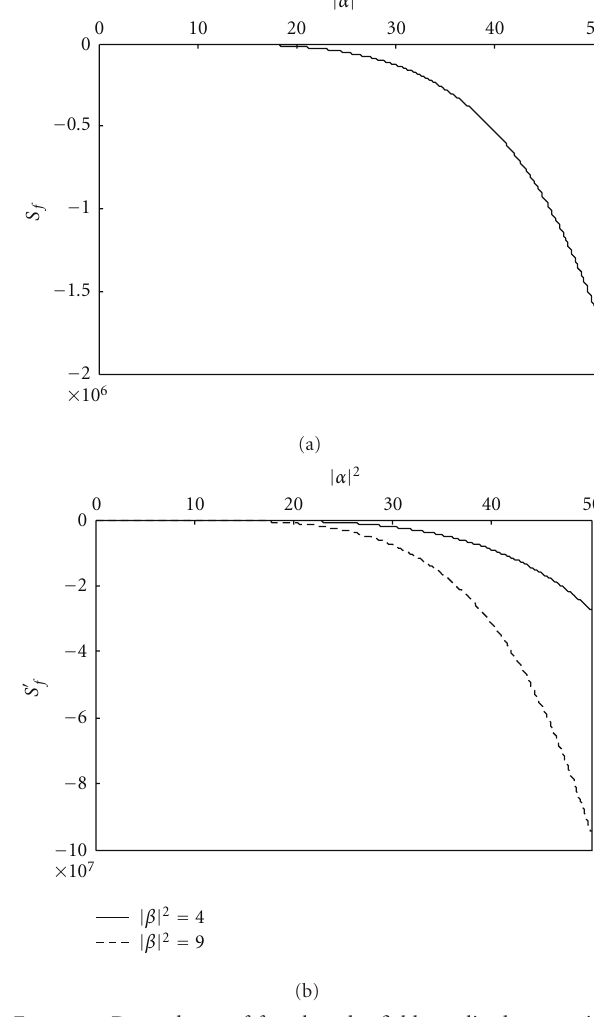
Figure 5: Dependence of fourth-order field amplitude squeezing (a) S f with | α | 2 in spontaneous and (b) S (cid:6) stimulated six-wave mixing process.